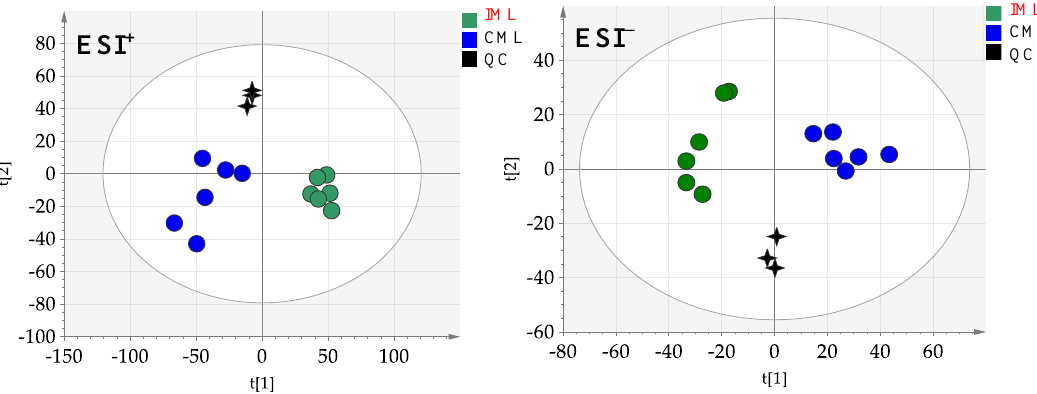
Figure 3. The principal component analysis (PCA) of CML and IML in ESI + mode and ESI − mode.